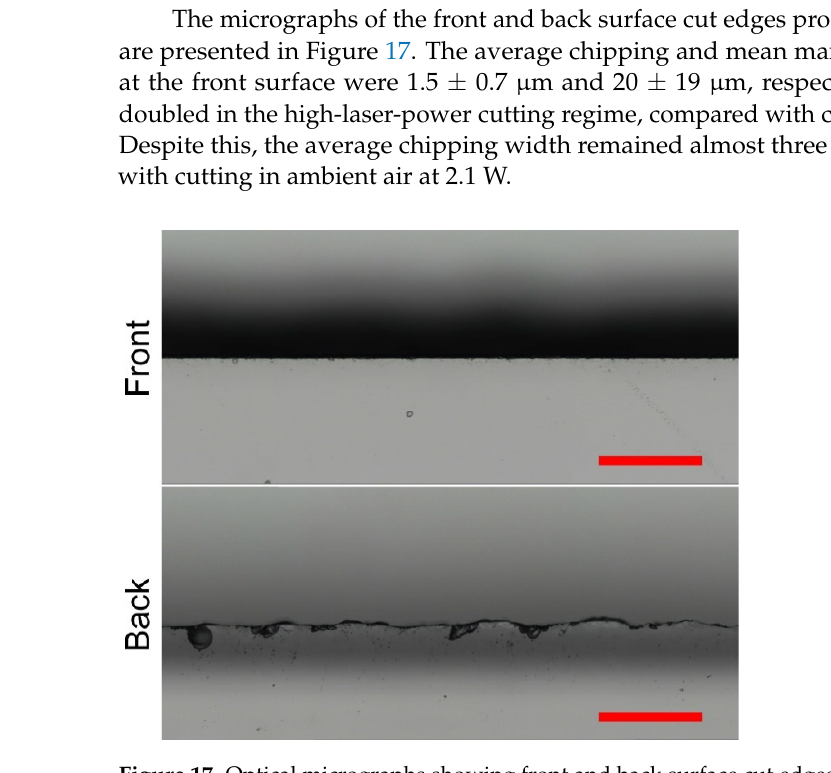
Figure 17. Optical micrographs showing front and back surface cut edges. Cutting was performed in water at 15.5 W. The scale bars represent 200 µm and apply to all panels in the figure.